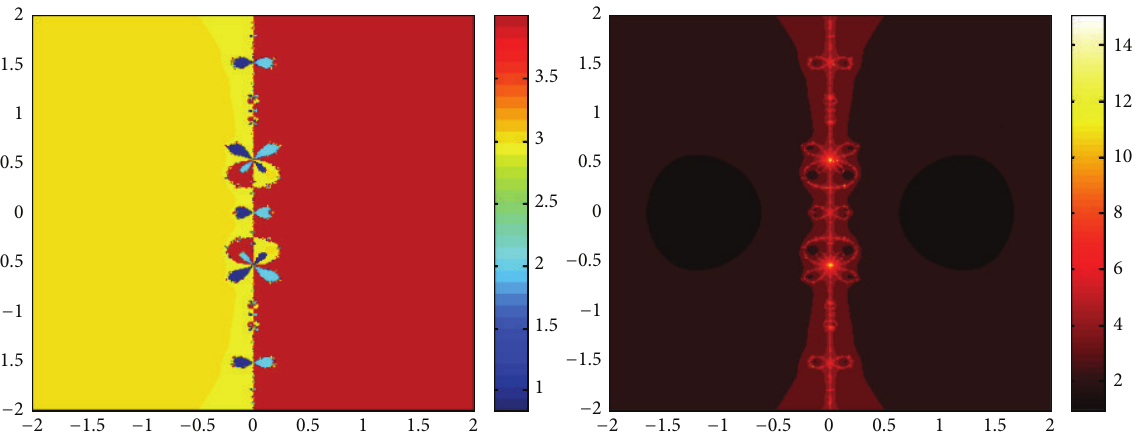
Figure 4: Basins of attraction of method (7) for 𝑝 4 (𝑥) .